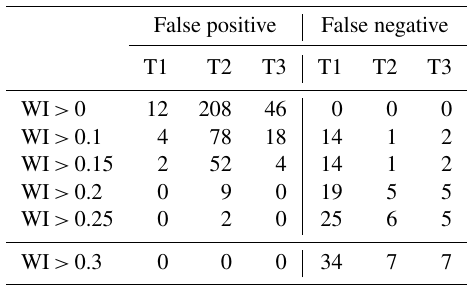
Table 7. False positives and negatives for the different threshold values and land uses. False